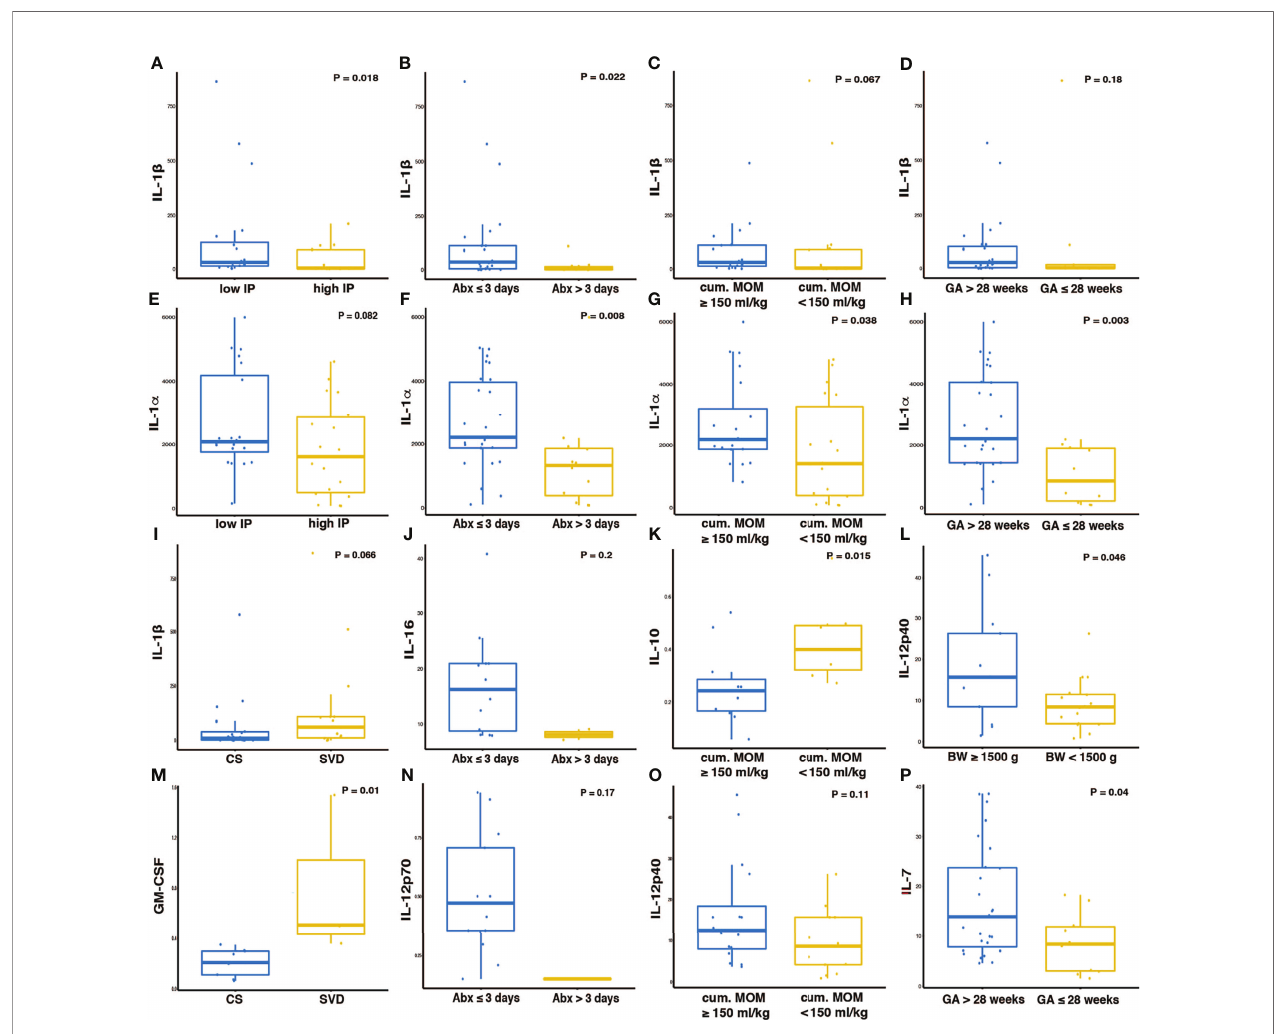
FIGURE 3 | IL-1 a and IL-1 b linked to lower IP and improved neonatal factors. Boxplots of the cytokine levels: (A-D, I) IL-1 b , (E – H) IL-1 a , (J) IL-16, (K) IL-10, (L, O) IL-12p40, (M) GM-CSF, (N) IL-12p70, (P) IL-7 between different categories. Plotted are interquartile ranges (IQRs, boxes), medians (line in box), and mean (red diamond). Signi fi cance value was calculated using Wilcoxon rank sum test using ggsignif R package (41). Asterisk denotes the level of signi fi cance. Threshold for early or late gestational age is 28 weeks, for low or high birth weight is 1,500 g, for longer or shorter abx exposure is 3 days during the fi rst week after birth prior to IP measurement, for maternal breast milk feeding is 150-180 ml/kg of cumulative intake of MOM by 7-10 days of age, according to clinical convention and previously validation (35, 36). IP, intestinal permeability; GA, gestational age; BW, birth weight; MOM, mother ’ s own breast milk (MOM) cumulative volume use during the fi rst week prior to IP measurement; SVD, spontaneous vaginal delivery; CS, cesarean